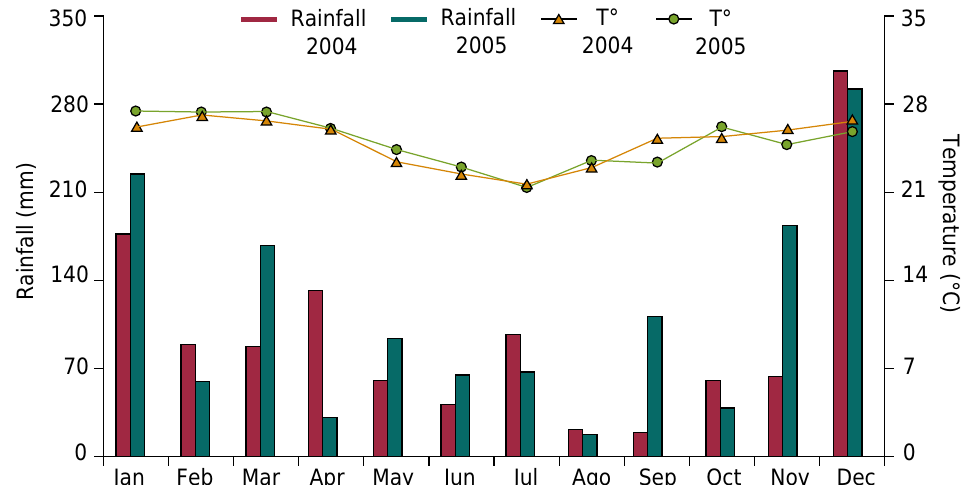
Figure 1. Monthly temperature and rainfall means for the years 2004 and 2005, recorded by the Leonel Miranda meteorological station in Campos dos Goytacazes, RJ,